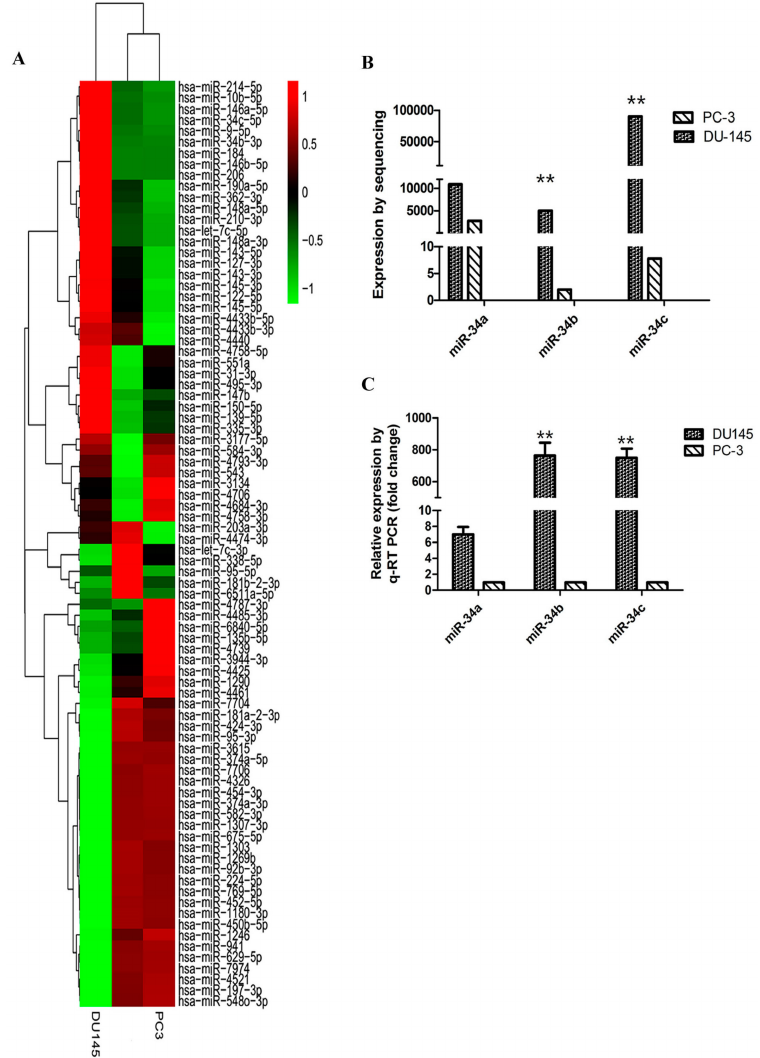
Figure 2. Expression levels of miR-34a, miR-34b, and miR-34c in prostate cancer cell lines DU145 and PC3. ( A ) Heat-map of miRNAs with differential expression comparing DU145 and PC3 cells. Up-regulated miRNAs are in red, whereas down-regulated genes are shown in green. Expression of miR-34b and miR-34c is up-regulated in DU145 cells and downregulated in PC3 cells; ( B ) Expression of miR-34a, miR-34b and miR-34c in DU145 and PC3 cells by miRNA sequencing analysis; ( C ) The relative expression of miR-34a, miR-34b, and miR-34c in DU145 and PC3 cells by qRT-PCR analysis. ** p < 0.01. Per condition, three independent experiments were